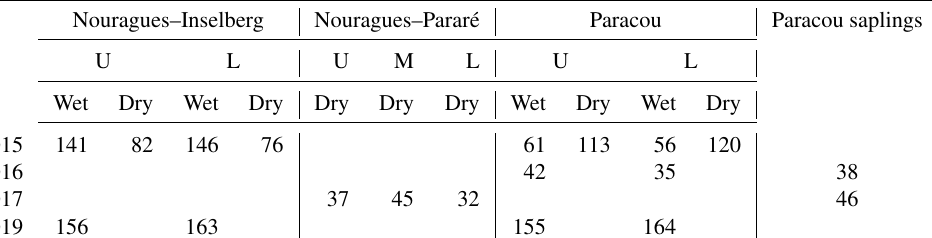
Table 3. Overview of the number of A n - C i curves measured in this study. Measurements were carried out in the wet and dry season at different canopy levels (U = sunlit upper-canopy leaves; L = shaded lower-canopy leaves; M = middle-canopy leaves) and at different field sites (Nouragues–Inselberg, Nouragues–Pararé, Paracou). The measurements carried out on saplings instead of on mature canopy trees are mentioned separately. Pre-treatment measurements were carried out in 2015 and 2016, whereas post-treatment measurements (after 1 and 3 years of nutrient addition) were carried out in 2017 and 2019. Nouragues–Inselberg Nouragues–Pararé